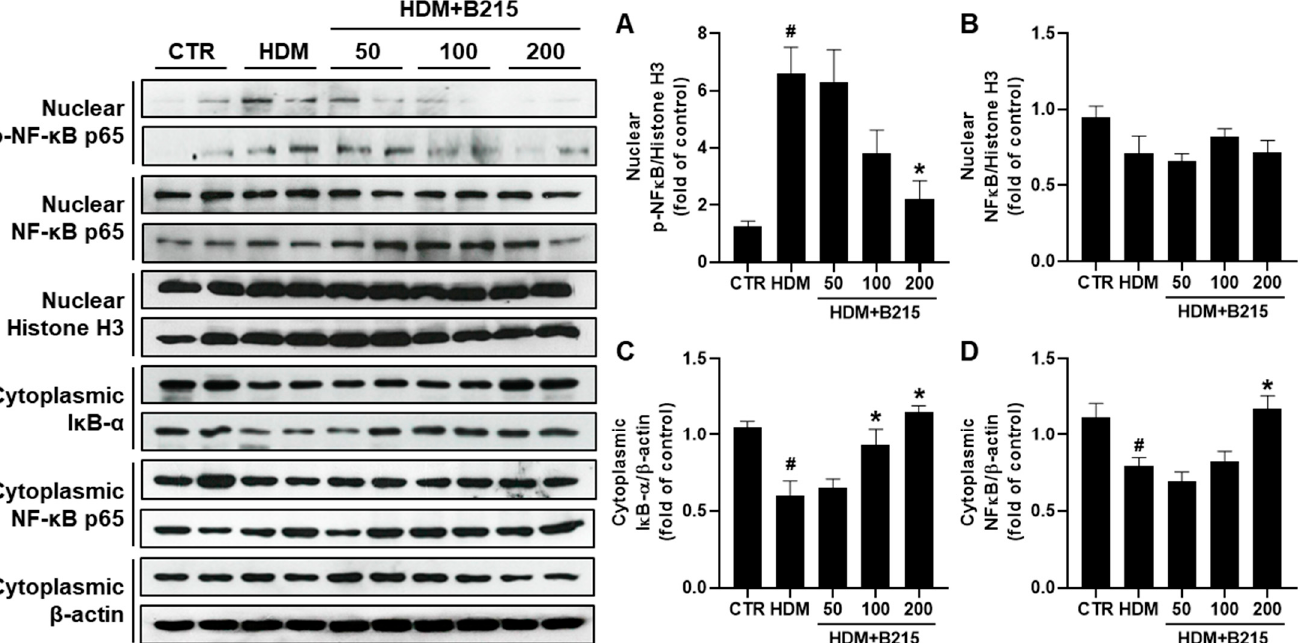
Figure 6. Effect of B215 on NF- κ B activation in HDM-induced lung inflammation model. Nucleus was separated from the cytoplasm, and protein was extracted to assess the translocation and phosphorylation of NF- κ B and degradation of I κ B through immunoblotting. Relative levels of ( A ) phosphorylated NF- κ B in nucleus, ( B ) total NF- κ B in nucleus, ( C ) I κ B- α in cytosol, and ( D ) total NF- κ B in cytosol were presented. β -actin and Histone H3 were used as an internal control. Data are presented as mean ± SD (# and *, p < 0.05, compared to CTR and HDM, respectively).